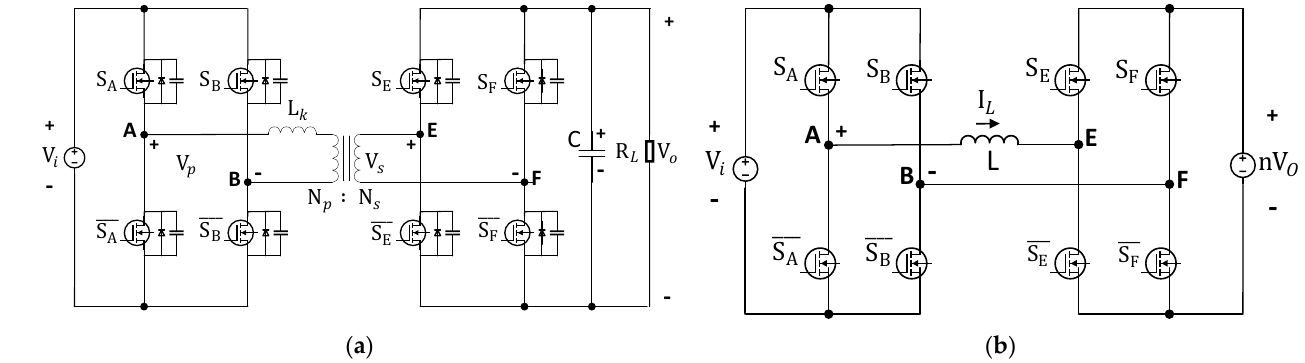
Figure 2. Dual Active Bridge DC-DC converter [7]: ( a ) Circuit diagram; ( b ) Simplified equivalent DAB circuit for inductor current behavior analysis.